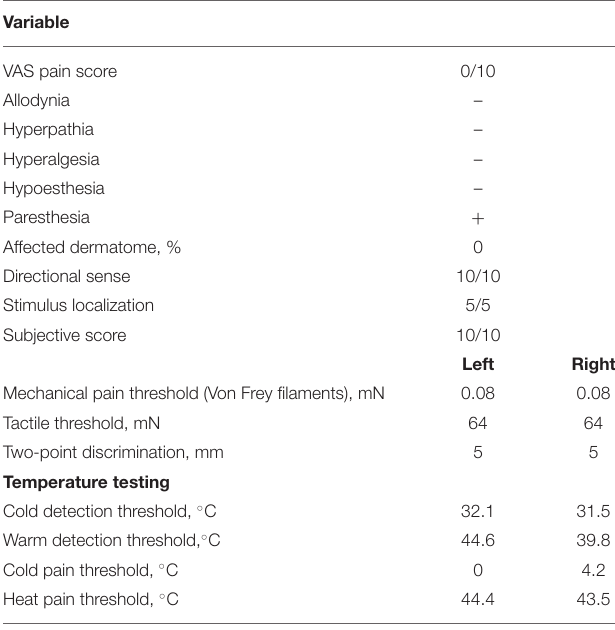
TABLE 1 | Quantitative sensory testing according to the DFNS protocol.